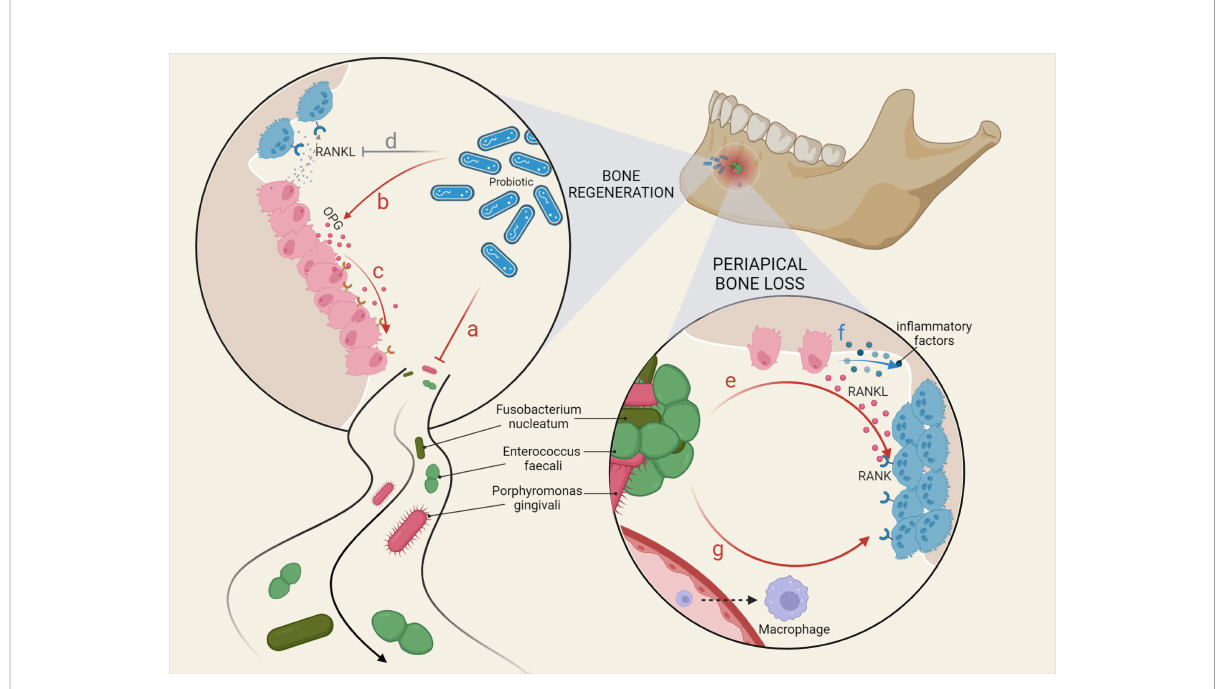
FIGURE 1 Main microbial factors affecting bone remodeling in CAP. Various oral microorganisms ultimately affect the in fl ammatory response and bone damage in the periapical region by in fl uencing the physiological functions of macrophage differentiation and osteoblast and osteoclast metabolism. Bone regeneration: (A) Probiotics inhibit pathogenic bacteria. (B) Probiotics promote OPG expression by OBs. (C) OPG competitively inhibits the binding of RANK to RANKL. (D) Probiotics downregulate RANKL produced by OBs. Periapical bone loss: (E) Fusobacterium nucleatum and Enterococcus faecali stimulate OBs to produce RANKL, binding to RANK on OCs. (F) OBs are stimulated to secrete a variety of in fl ammatory factors, triggering greater bone loss. (G) LPS recruits macrophages from the blood and LTA promotes the differentiation of macrophages towards